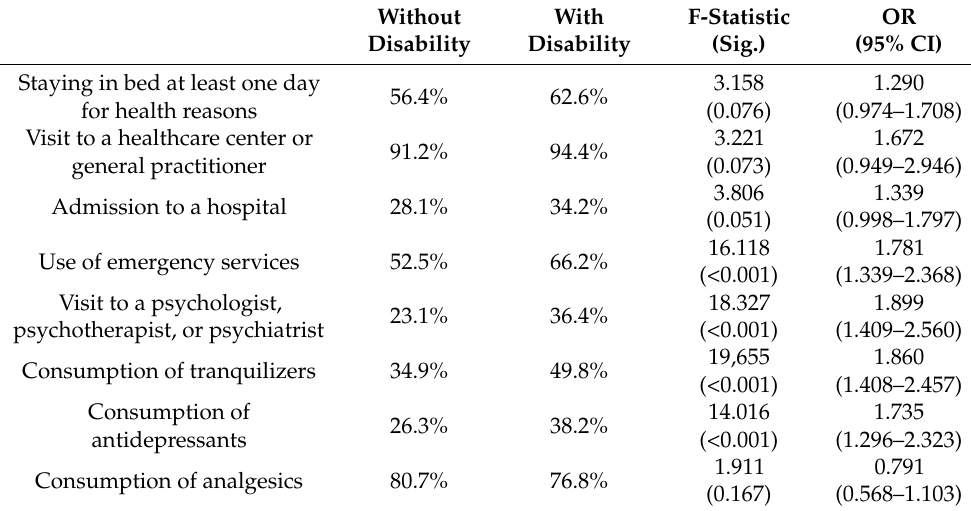
Table 3. Incidence of disability on women’s health and the use of healthcare